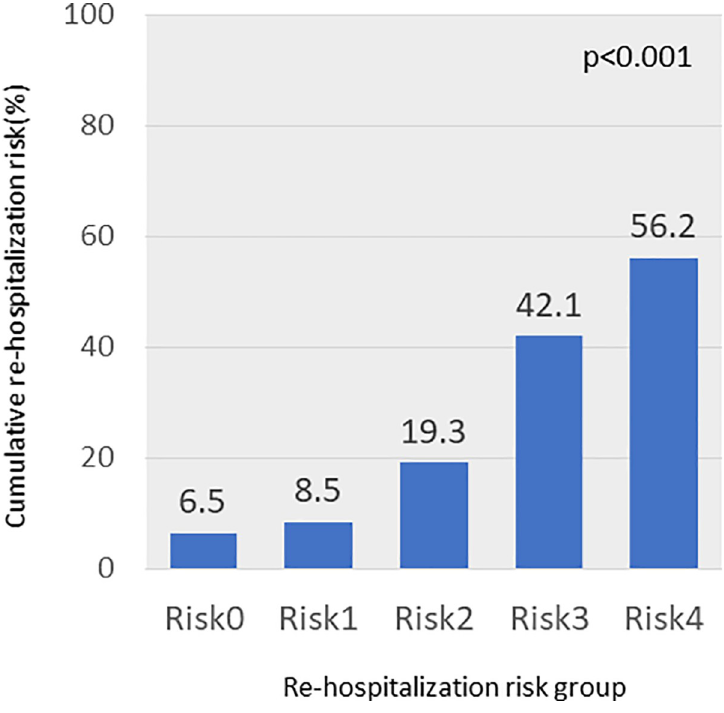
Fig 2. Cumulative re-hospitalization risk. Rates of re-hospitalization for congestive heart failure in the validation subset based on their risk score.